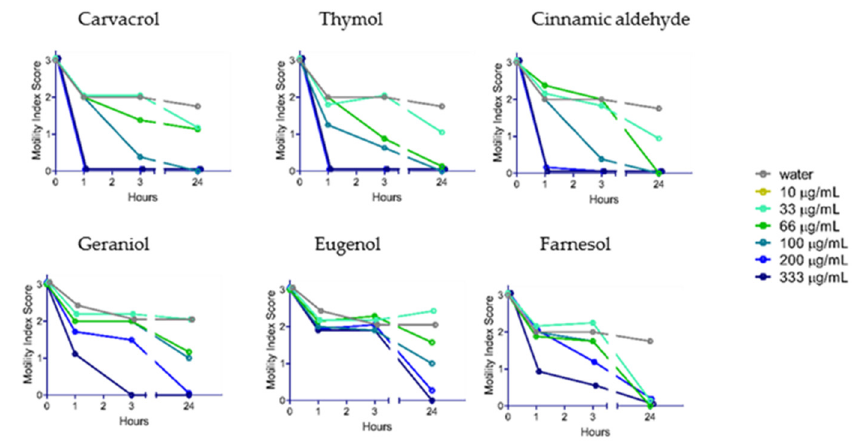
Figure 4. Effect of select YP-terpenes on N. brasiliensis. N = eight adult worms/condition.